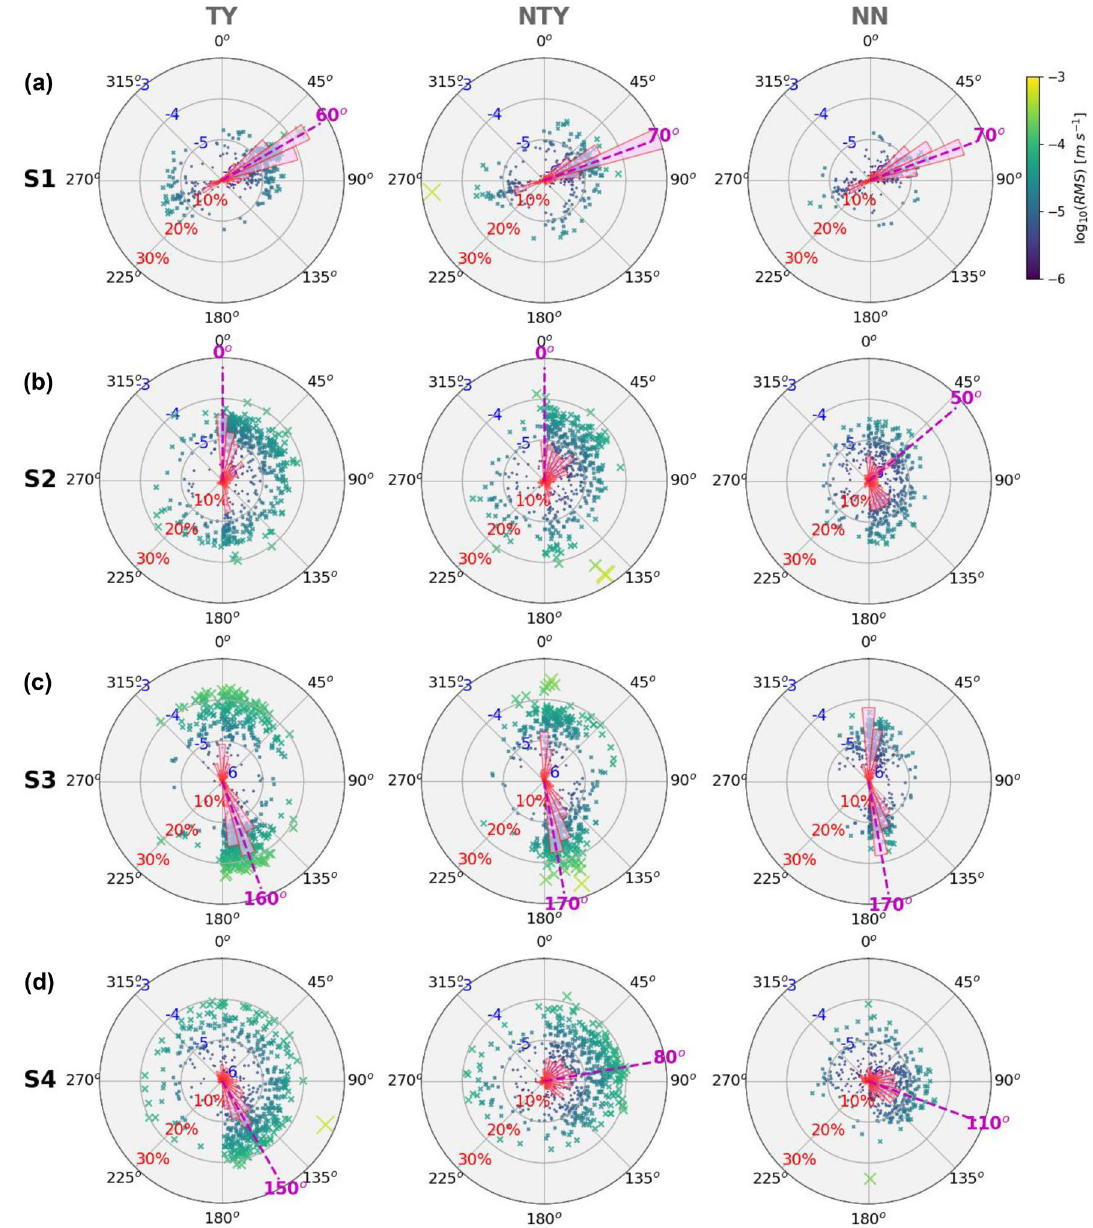
Figure 6. Back azimuths of turbulence sources determined from the maximum root-mean-square (RMS) of the rotated horizontal velocity waveform in every 15-min time window with half window shifts at OBS ( a ) S1, ( b ) S2, ( c ) S3, and ( d ) S4 during the TY, the NTY, and the NN periods. The colors of the crosses show the amplitude of the RMS. Pink bars show the statistical percentages of the back azimuths in every ten-degree sector at each OBS. The purple dashed line shows the maximum percentage of the back